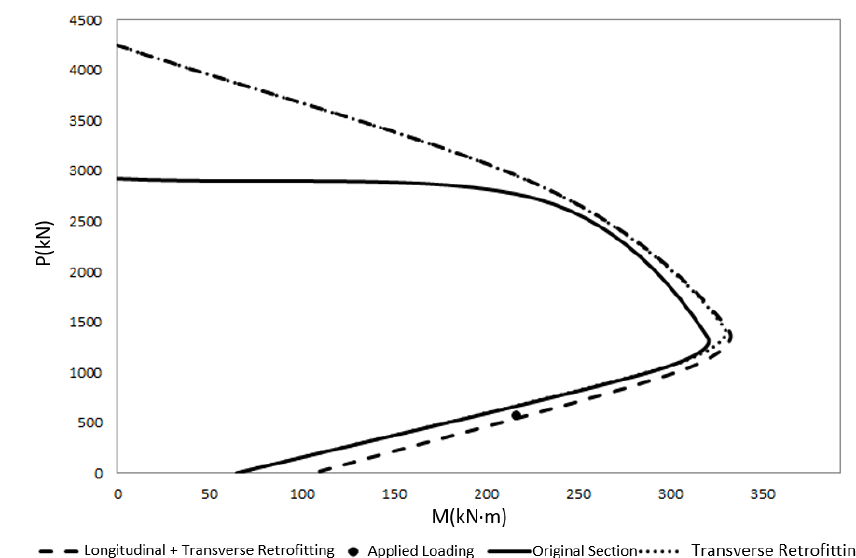
Figure 9. Interaction curve for different retrofitting states.